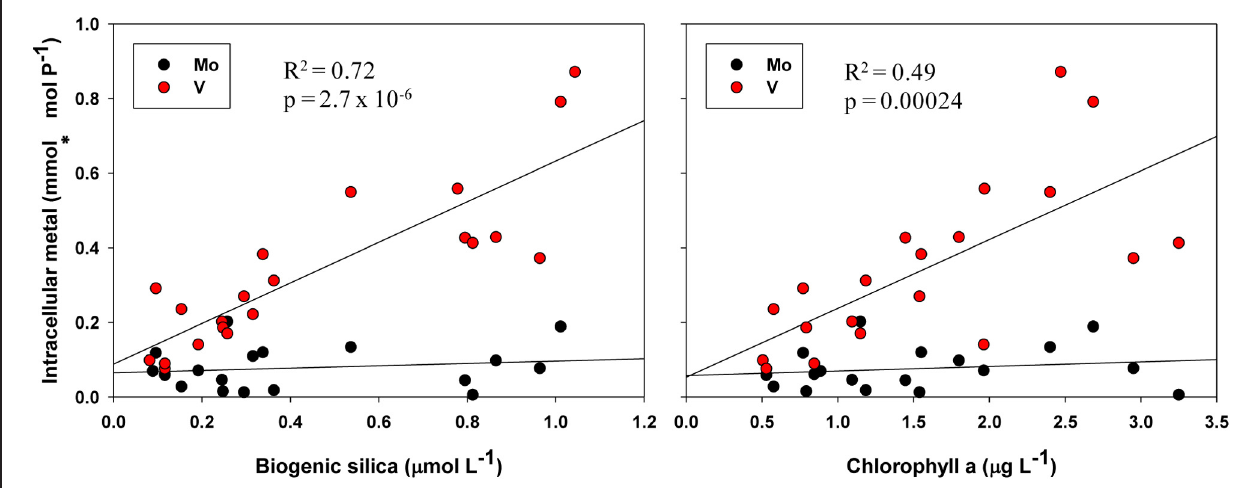
FIGURE 6 | Oxalate-washed particulate V:P and Mo:P vs. biogenic silica and total chlorophyll a across the entire NASB transect. R 2 and p -values are given for linear regressions of the independent variable vs. intracellular V. Regressions against particulate Mo:P were not statistically significant.